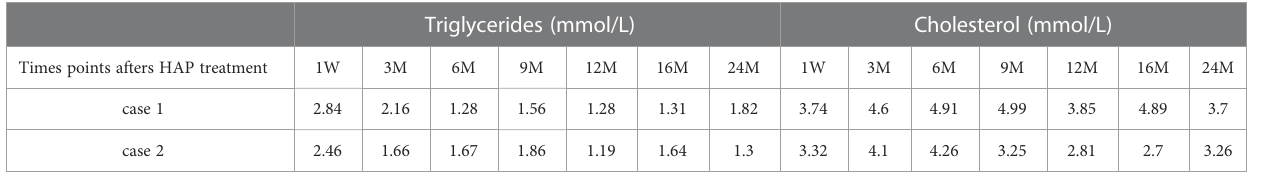
TABLE 1 Triglycerides and cholesterol level for 24 months after HAP